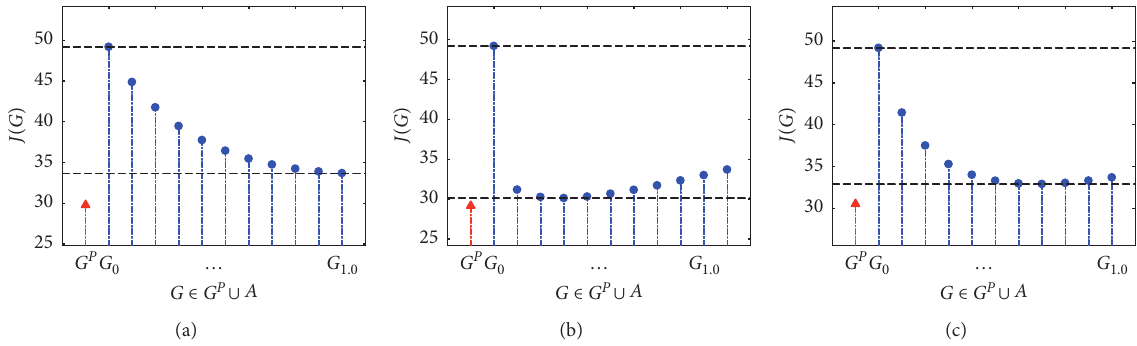
( x ) , θ ( x )) functions: (a) θ 1 2 ( x ) . 2